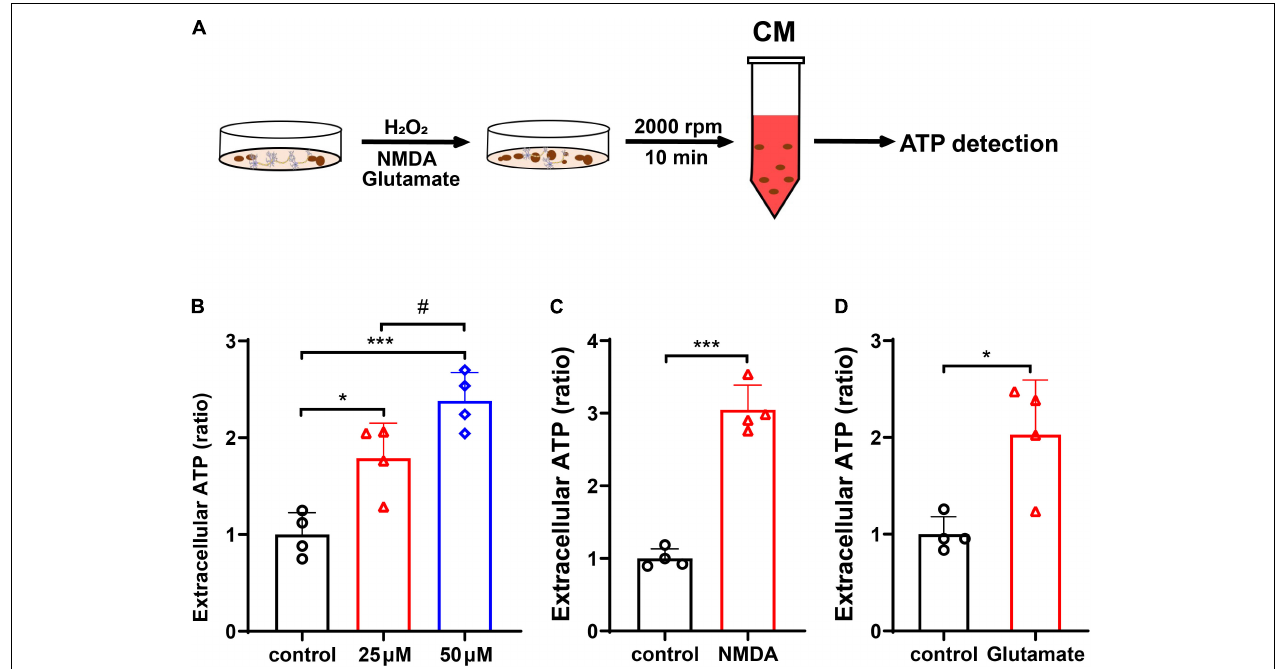
FIGURE 3 | Neurons released mitochondria under hydrogen peroxide (H 2 O 2 )-mediated oxidative stress and glutamate- and N -methyl- D -aspartate (NMDA)-induced excitotoxicity. (A) The experimental procedure. (B) The extracellular ATP increased dose-dependently in CM after H 2 O 2 treatment. (C,D) The extracellular ATP increased significantly after treatment with NMDA (50 µ M) or glutamate (100 µ M). n = 4. * p < 0.05, *** p < 0.001 vs. control, # p < 0.05 vs. 25 µ M H 2 O 2